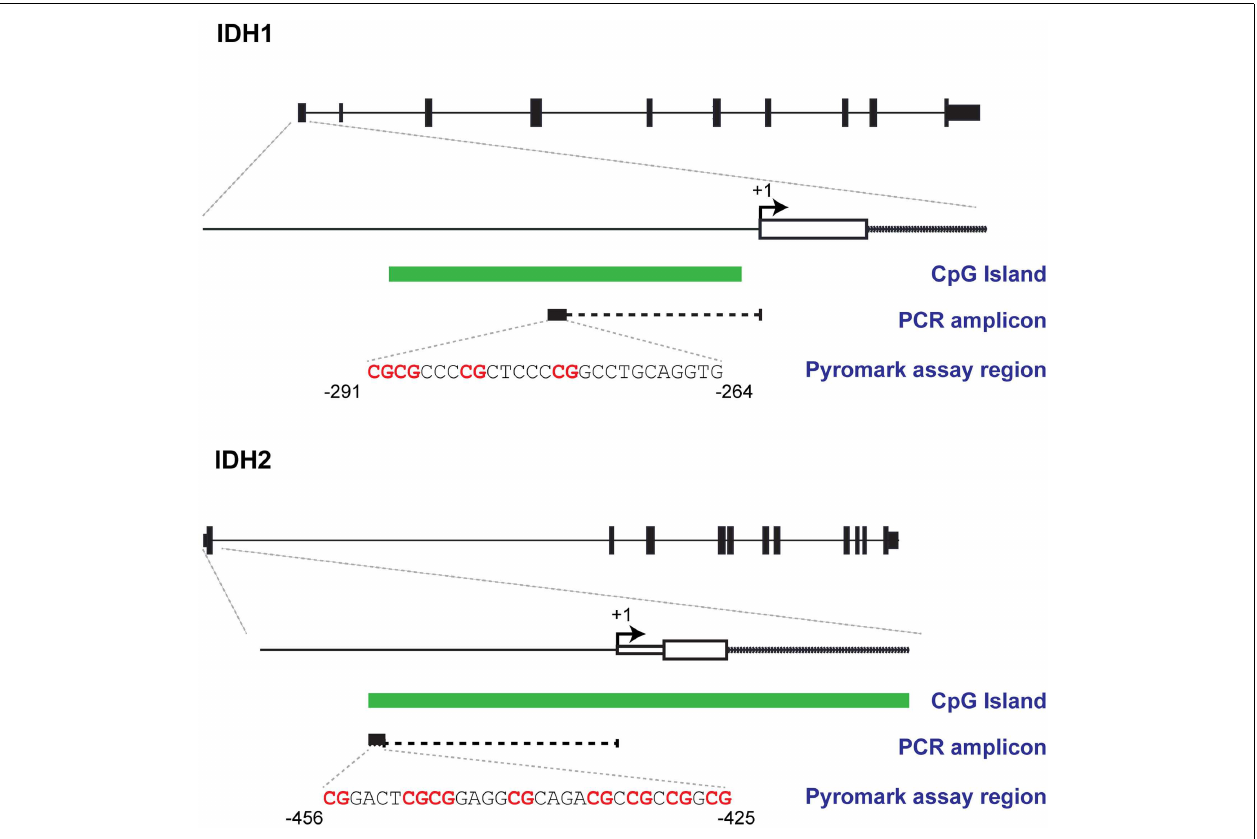
FIGURE 1 | Bisulphite Pyrosequencing designs. Schematics showing regions targeted for methylation analysis and their relationships with CpG islands and transcription start sites of IDH1 and IDH2